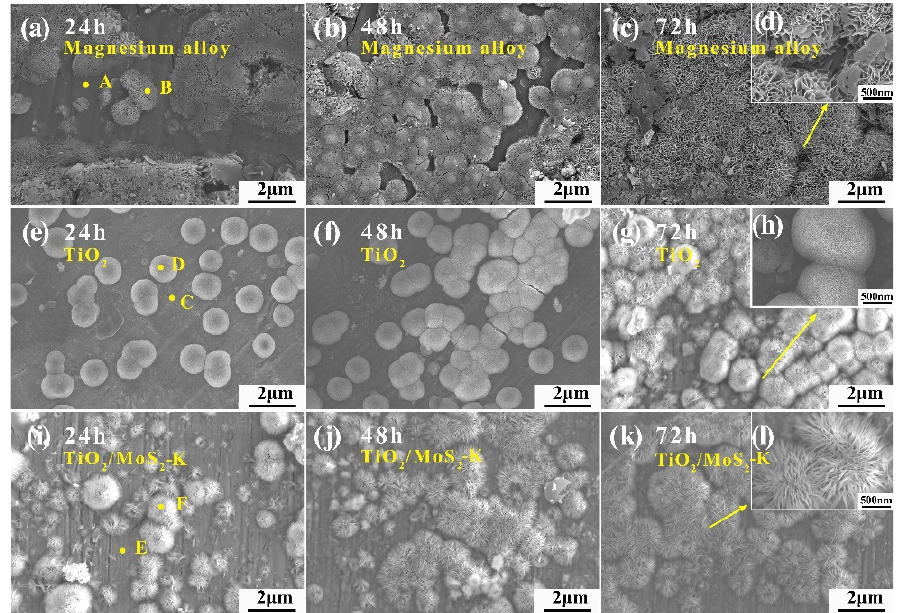
Figure 9. The microstructure of the sample surface after salt spray test at different times. Magnesium alloy: ( a ) 24 h, ( b ) 48 h, ( c ) 72 h; TiO 2 film: ( e ) 24 h, ( f ) 48 h, ( g ) 72 h; TiO 2 /MoS 2 -K film: ( i ) 24 h,